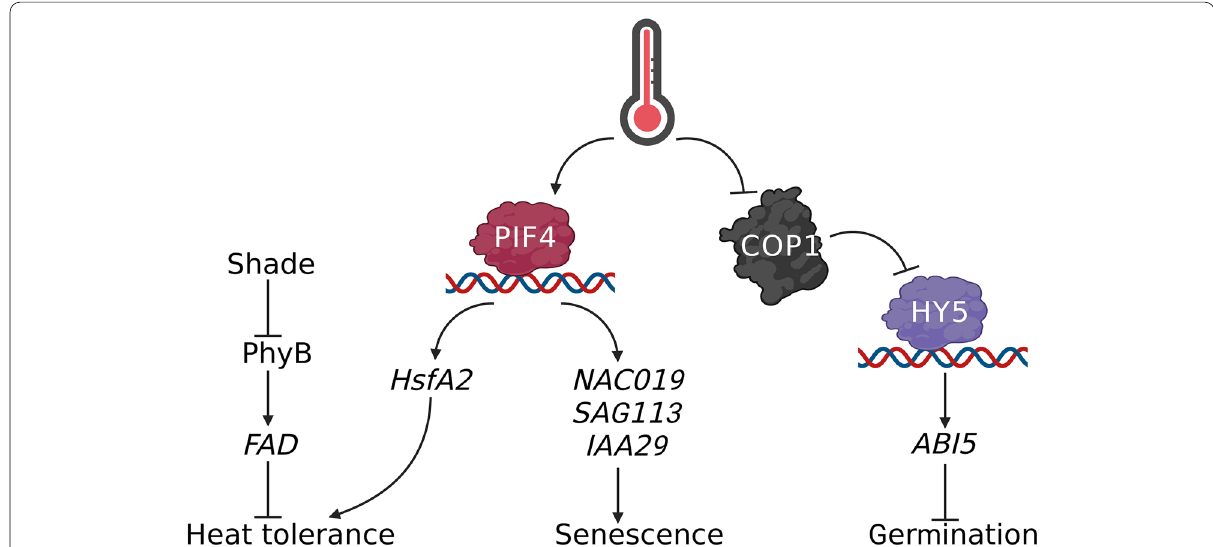
Fig. 2 Roles of the major light signaling components in plant heat responses. Light activated transcription factor PIF4, which directly induces HsfA2 expression to confer seedling heat tolerance. However, PIF4 also triggers senescence associated gene ( NAC019 , SAG113 and IAA29 ) expressions in adult plants to induce plant senescence. Simulated shade enhances plant heat tolerance through the repression of FAD expression to reduce the total unsaturated fatty acids. Heat also inhibits COP1 activity to stabilize HY5, which directly induces ABI5 expression to repress seed